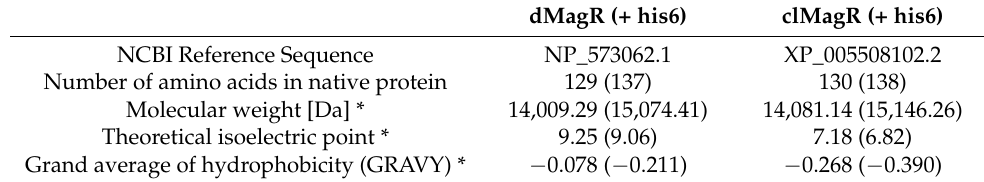
Table 1. Overview of protein specific